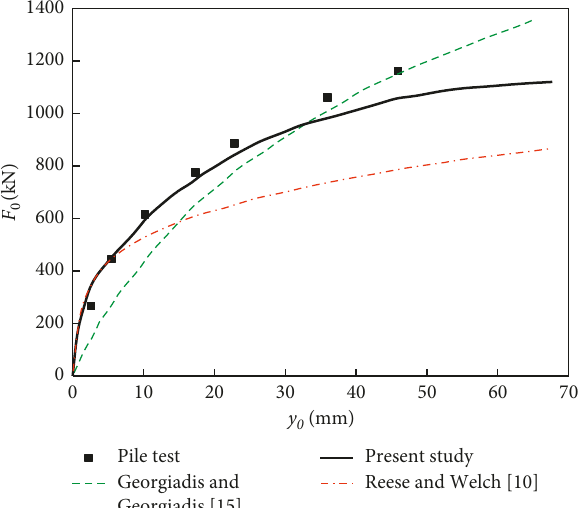
Figure 7: Comparison of lateral load ( F curves among model tests and theoretical